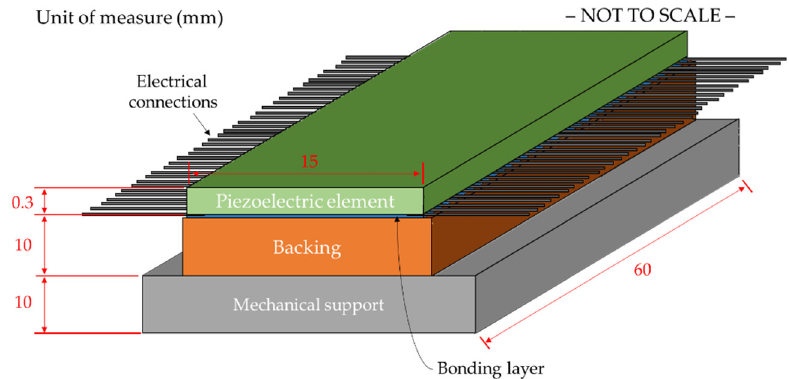
Figure 5. Structure of the US probe under test at stage #3.